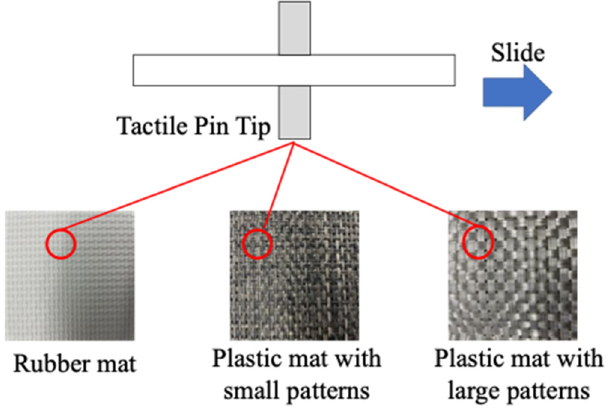
Figure 13. Contact situation between a tactile pin tip and material surface.